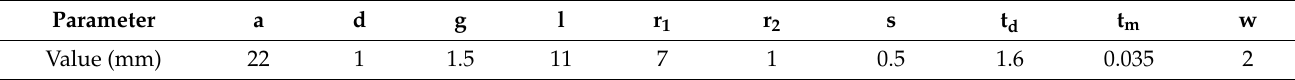
Table 1. Structural parameters of the